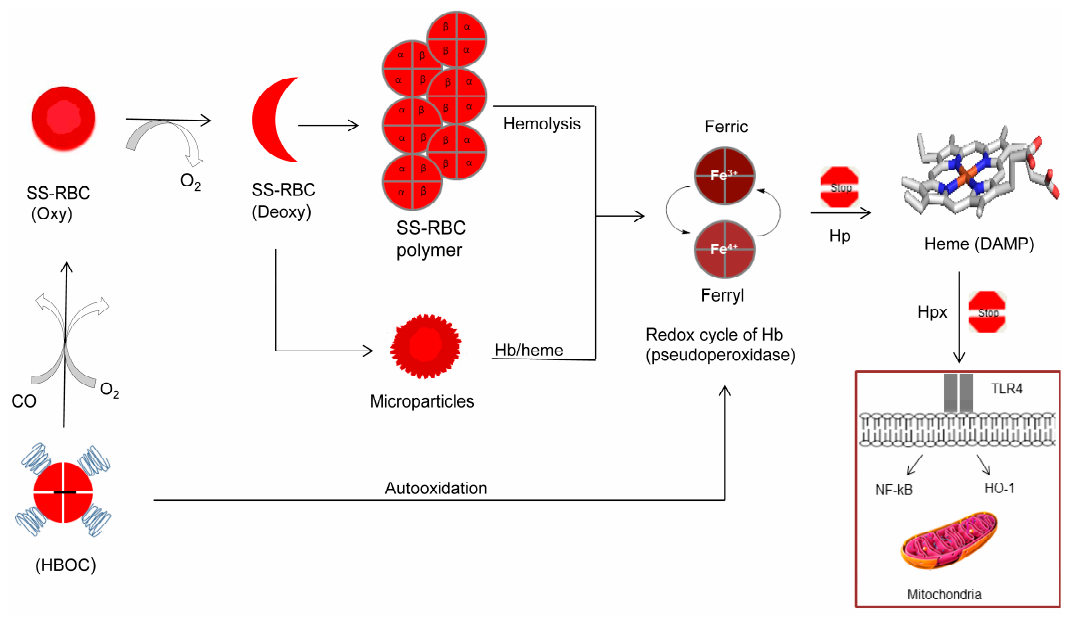
Figure 1. Proposed antisickling functions of hemoglobin-based oxygen carriers (HBOCs) and possible complications of heme oxidative pathways. Red blood cell with predominately sickle cell hemoglobin (HbS) undergoes a vicious sickling and unsickling cycle in the microvasculature resulting in deoxyHbS fibers and free hemoglobin (Hb) spilling out of ruptured cells. Hb-laden microparticles release their contents (Hb and heme). Free Hb undergoes uncontrollable oxidation and oxidative changes through its classic pseudoperoxidase activity (redox cycling between ferric and ferryl heme) resulting ultimately in the loss of heme. Heme as damage associated molecular pattern (DAMP) molecule triggers Toll-like receptor 4 (TLR4), nuclear factor kappa-light-chain-enhancer of activated B cells (NF-kB), and heme oxygenase-1 (HO-1) activation. This leads to inflammatory responses and altered cell metabolism, including mitochondrial dysfunction. Haptoglobin (Hp) (protein scavenger) and hemopexin (Hxp) (heme scavenger) can effectively inhibit Hb oxidative side reactions and heme toxicity. HBOCs due to their relatively smaller sizes can reach microvasculature and by delivering oxygen (O 2 ) and/or carbon monoxide (CO) may reverse sickling. However, HBOCs may aggravate oxidative stress by initiating its own damaging oxidative pathways. SS RBCs: sickle cell red blood